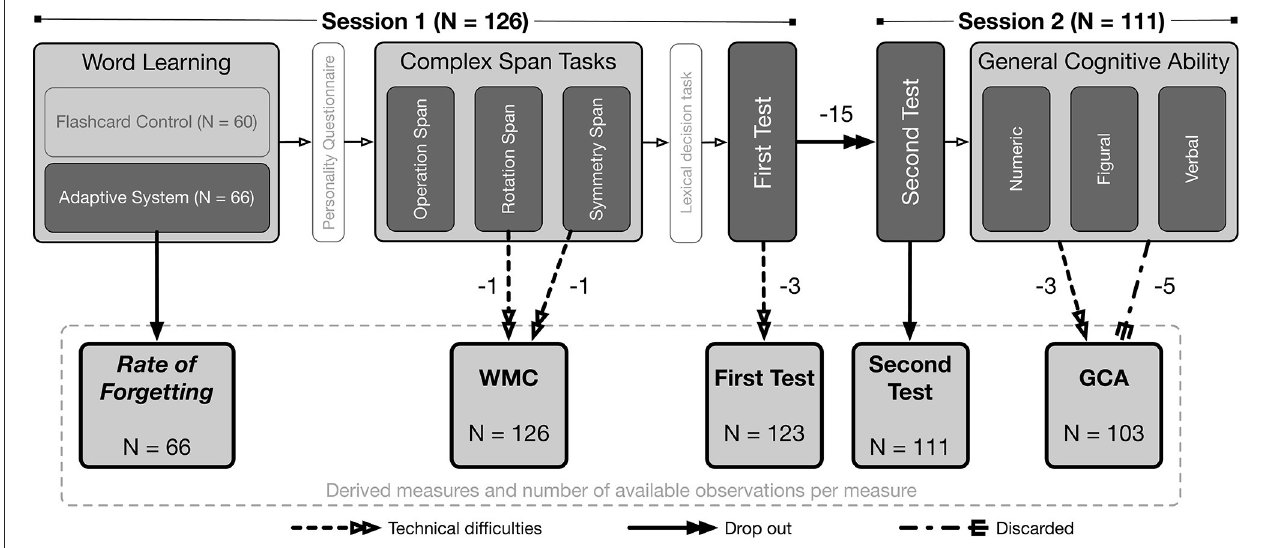
FIGURE 1 | Overview of the administered tasks, of the derived measures, and of how many participants’ data was not available and the reasons for data loss. Boxes without fill correspond to tasks that participants completed but that were not relevant for the current study.